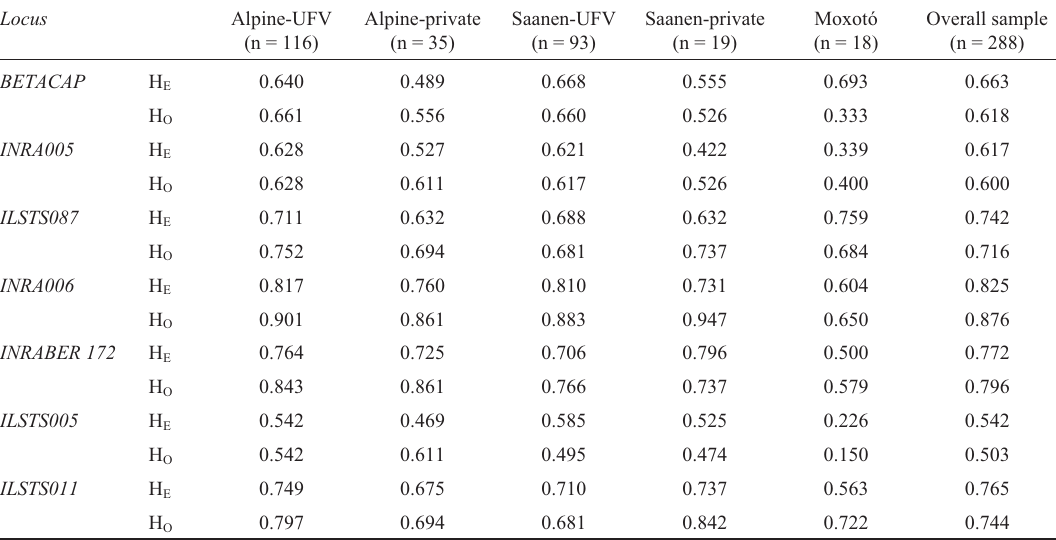
Table 2 - Effective sample size (n) and expected and observed heterozygosity (H E and H O ) at each locus for the populations and for the overall sample. Alleles undetected in a specific population are indicated by a dash (-). Locus Alpine-UFV (n =